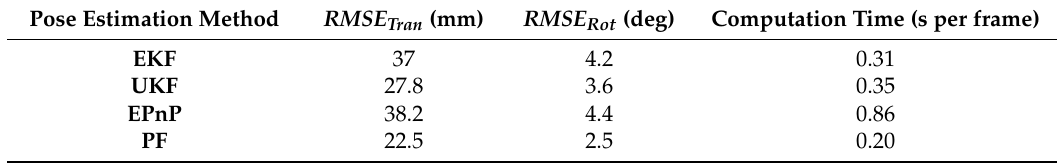
Table 3. Comparison of different camera pose estimation methods (reported values are average of five executions for each of the methods).